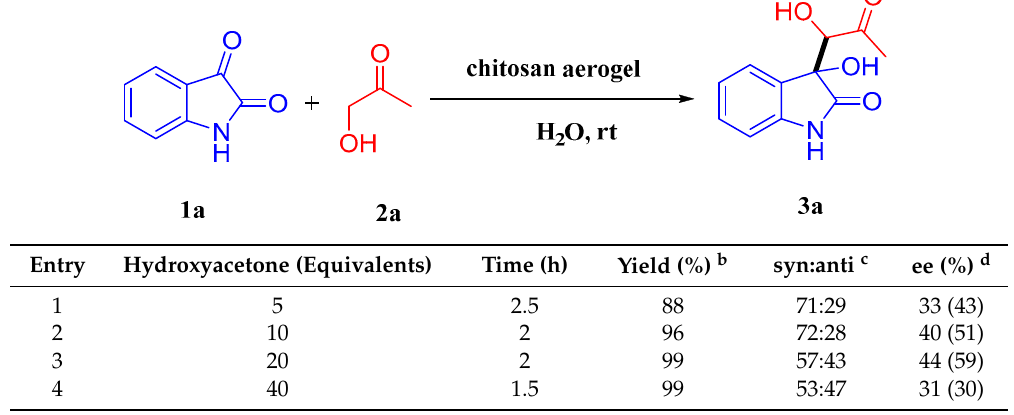
Table 3. Effects of additives for the enantioselective aldol reaction in the presence of water a